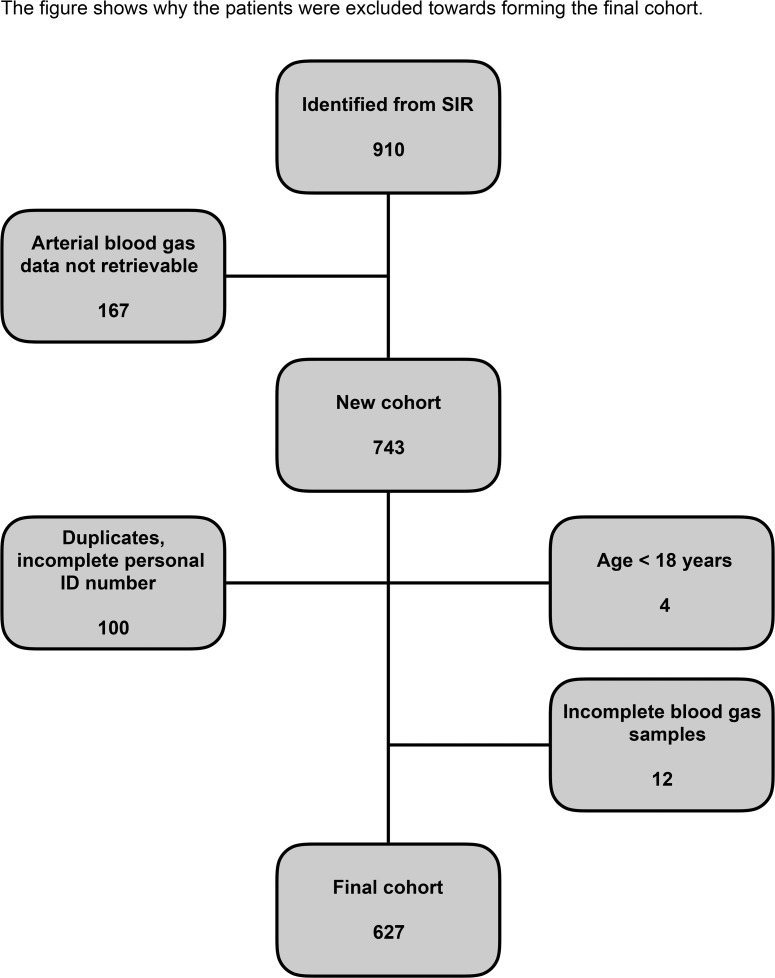
Flow chart of study population selection.